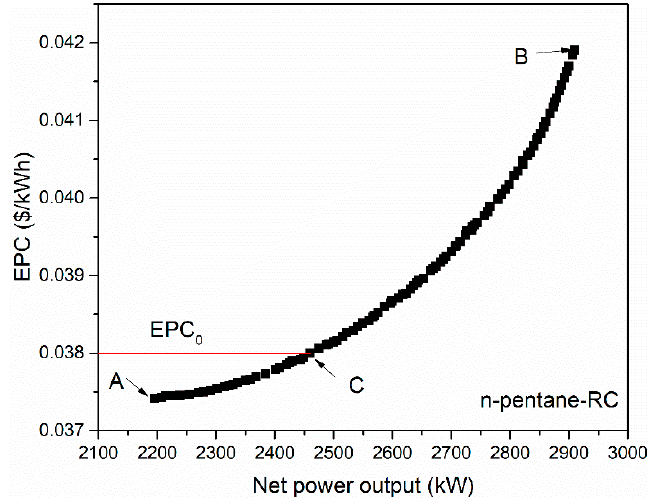
Figure 7. The Pareto frontier of EPC with net power output for an n-pentane-RC system.